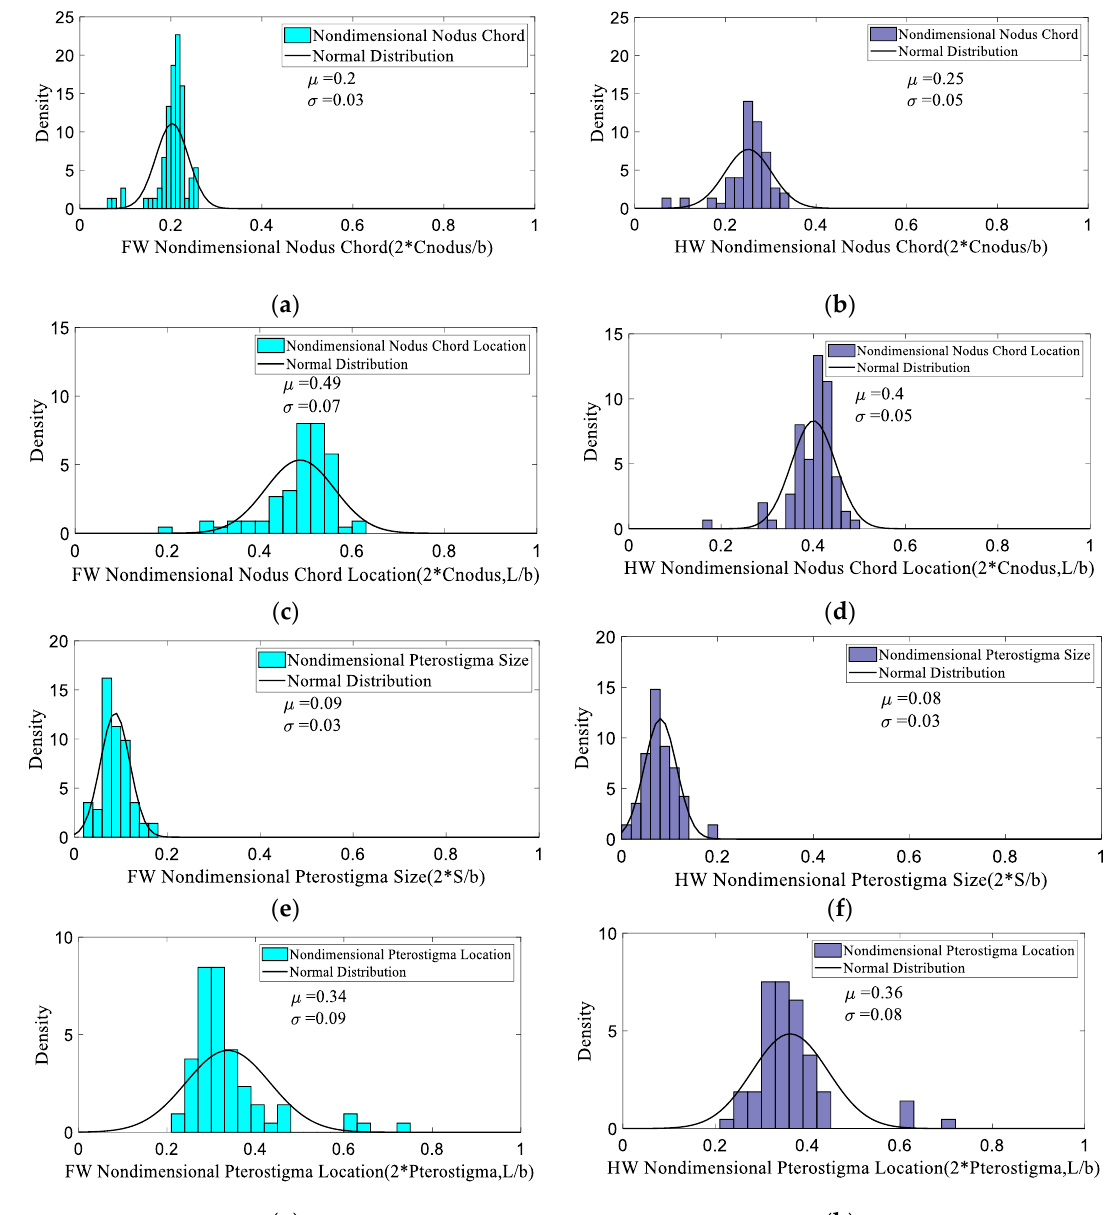
Figure 7. PDF and fitted normal distribution of FW nodus chord ( a ), HW nodus chord ( b ), FW nodus chord location ( c ), HW nodus chord location ( d ), FW pterostigma size ( e ), HW pterostigma size ( f ), FW pterostigma location ( g ) and HW pterostigma location ( h ).